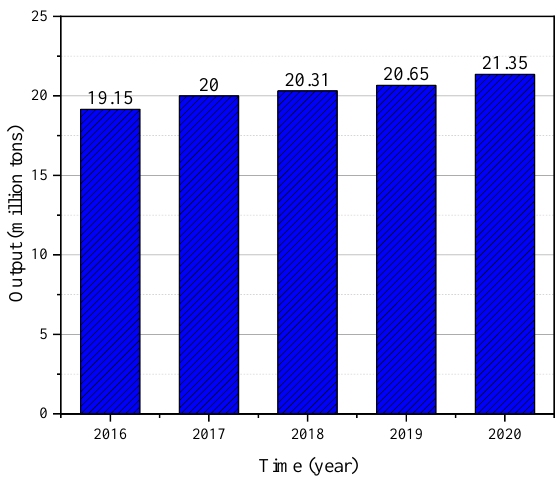
Figure 1. Annual mariculture output of China from 2016 to 2020.